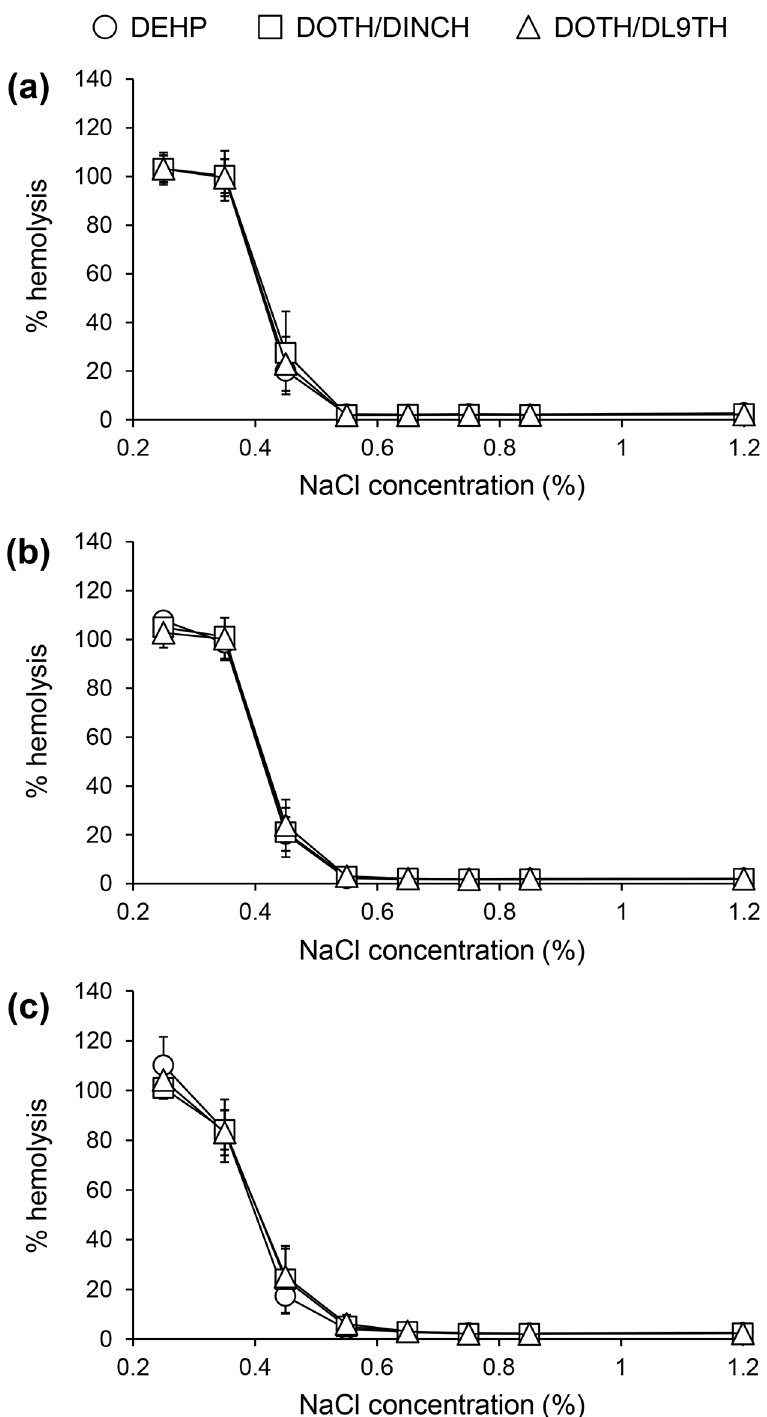
Fig 2. Osmotic fragility test of stored MAP/RCC. Hemolysis rate of MAP/RCC after 0 (a), 3 (b), and 6 weeks of storage (c) are shown. Data are reportedas mean ± SD (n = 6).